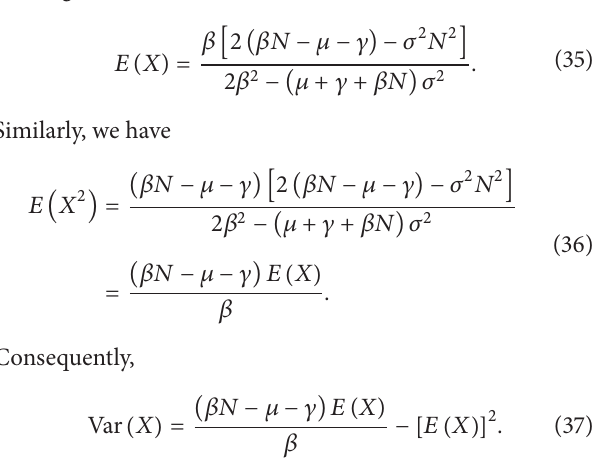
This together with (33) shows